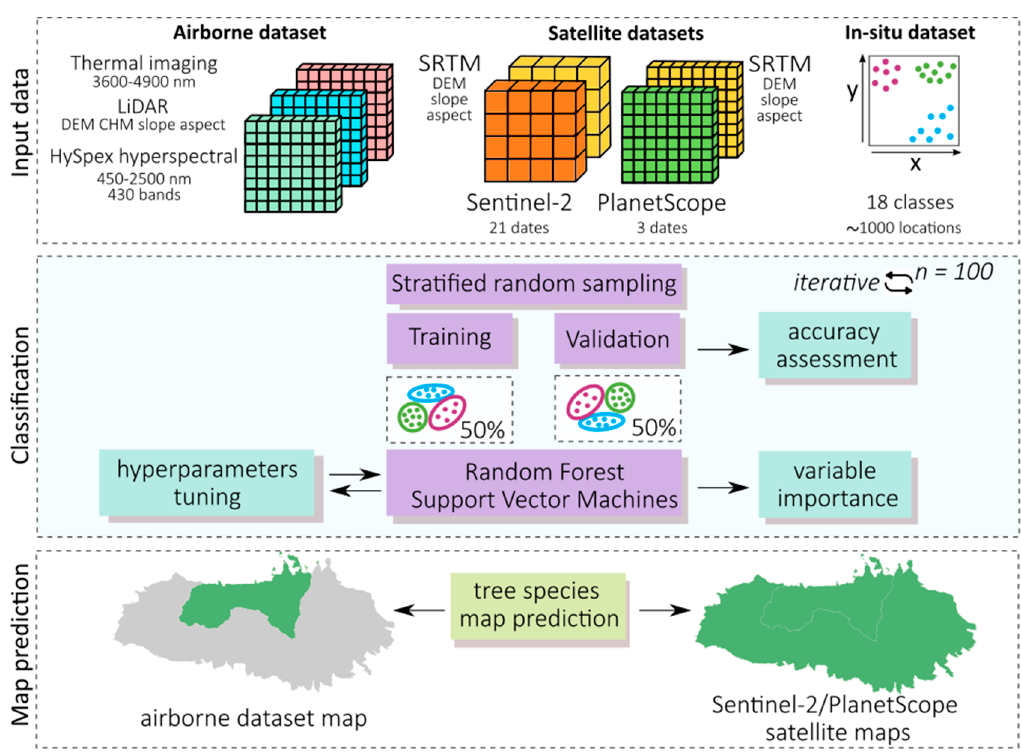
Figure 4. Main steps of processing procedure. As input data, we used: (1) airborne hyperspectral HySpex, thermal images, and LiDAR point cloud data; (2) multitemporal Sentinel-2, PlanetScope images, and Shuttle Radar Topography Mission (SRTM) satellite data; and (3) field-verified patterns of dominant tree species as reference data. First, we optimized the parameters of the random forest and support vector machine classifiers. Second, iterative classification was performed, repeating the procedure 100 times based on the prepared training and validation (50:50) sets. As output variables, we determined the importance of the used satellite spectral bands, obtained maps of tree species, and calculated their classification accuracies.